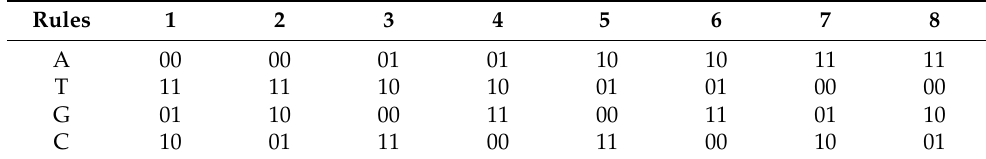
Table 1. DNA Base Complementary Rules.